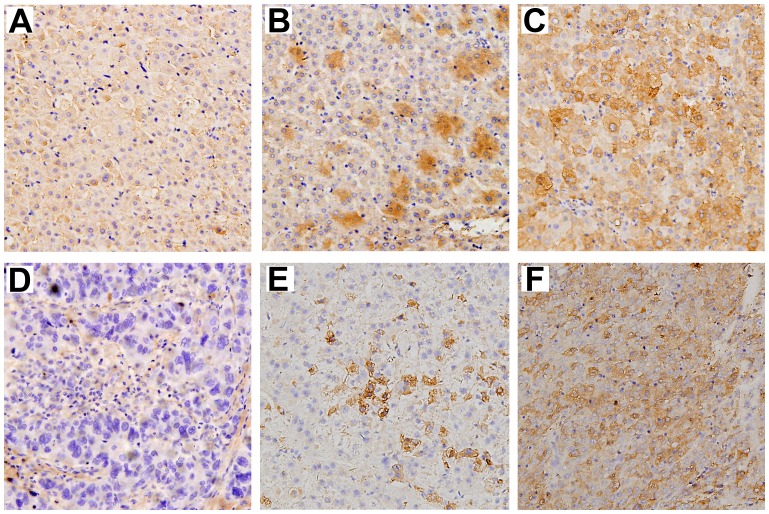
Representative immunohistochemistry staining of Nova1 in tumor and peritumoral tissues of HCC patients.Negative staining (A), moderate staining (B) and intense staining (C) of peritumoral tissues. Negative staining (D), moderate staining (E) and intense staining (F) of tumor tissues. Original magnification: ×200.